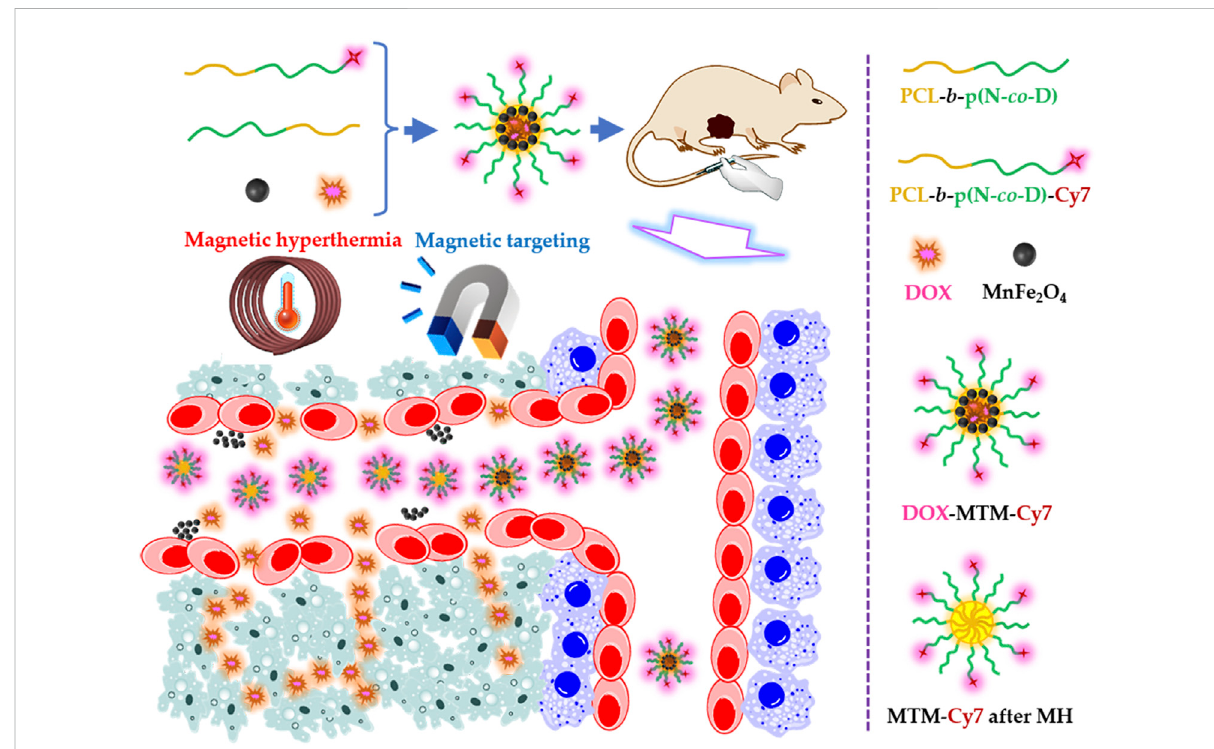
FIGURE 1 Schematic illustration of the doxorubicin (DOX)-loaded magnetothermally-sensitive micelle modi fi ed by Cy7 (DOX – MTM – Cy7) and its effect on enhancing DOX penetration under assistances of magnetic targeting and magnetic